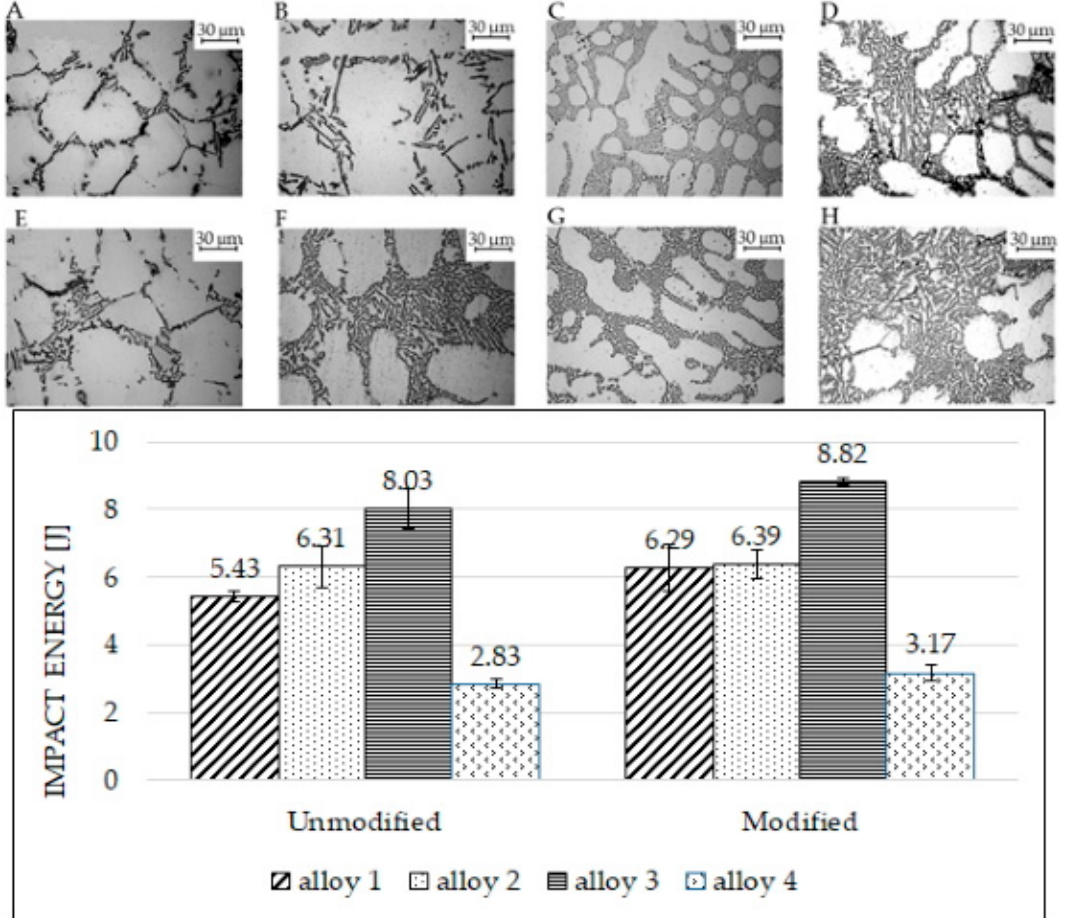
Figure 8. Impact test results and alloys' microstructures (optical microscope). Microstructures ( A – D ) refer to the unmodified alloys, as on the bar chart's left side. Microstructures ( E – H ) refer to the modified alloys, as on the bar chart's right side. Image ( A , E ): alloy 1; image ( B , F ): alloy 2; image ( C , G ): alloy 3; image ( D , H ): alloy 4. Figure 9 documents the relations between intermetallics and silicon shape observed.